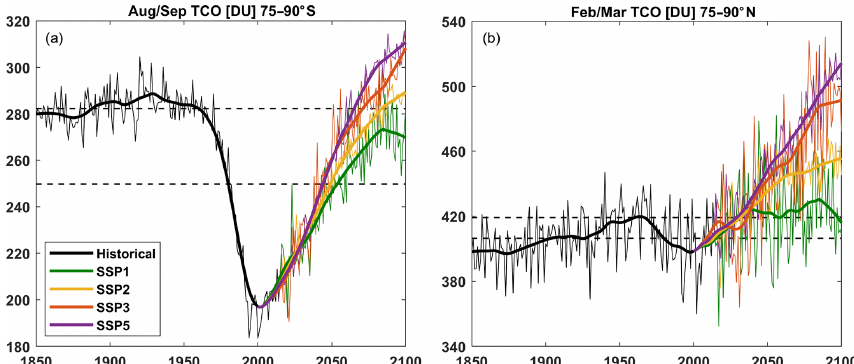
Figure 1. The time series of August/September Antarctic (a) and February/March Arctic (b) total column ozone from 1850 to 2100 in Dobson units. Black indicates 1850–2014 historical run (mean of three ensemble members), green indicates 2015–2100 SSP1 (one simulation), yellow indicates 2015–2100 SSP2 (mean of five ensemble members), red indicates 2015–2100 SSP3 (one simulation), and purple indicates 2015–2100 SSP5 (mean of five ensemble members). Thin lines are yearly averages and thick lines are the 31-year smoothed trend calculated with the LOWESS method. Smoothed trends for SSPs are calculated continuously with the historical run to avoid gaps around 2015 (note the SSP thick lines starting from the year 2000). Dotted lines represent the average level for the years 1960 and 1980.